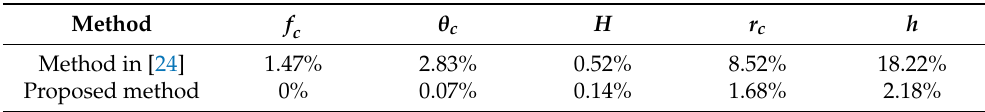
Table 5. Comparison of MAPEs between the proposed method and the method in [24]. (SNR = 15 dB).